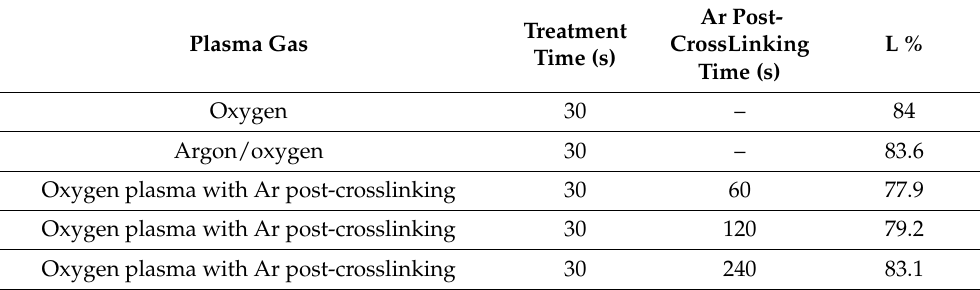
Figure 3. WCA of treated PBS substrates ( A ) immediately after plasma treatment, ( B ) after 4 h, ( C ) after 24 h, and ( D ) after 400 h. (a) Untreated PBS, (b) O 2 ‐ plasma ‐ treated for 30 s, (c) Ar/O 2 ‐ plasma ‐ treated for 30 s, (d) O 2 plasma 30 s + Ar plasma 60 s, (e) O 2 plasma 30 s + Ar plasma 120 s, and (f) O 2 plasma 30 s + Ar plasma 240 s. Table 2. Loss of treatment efficiency after 15 days of ageing.